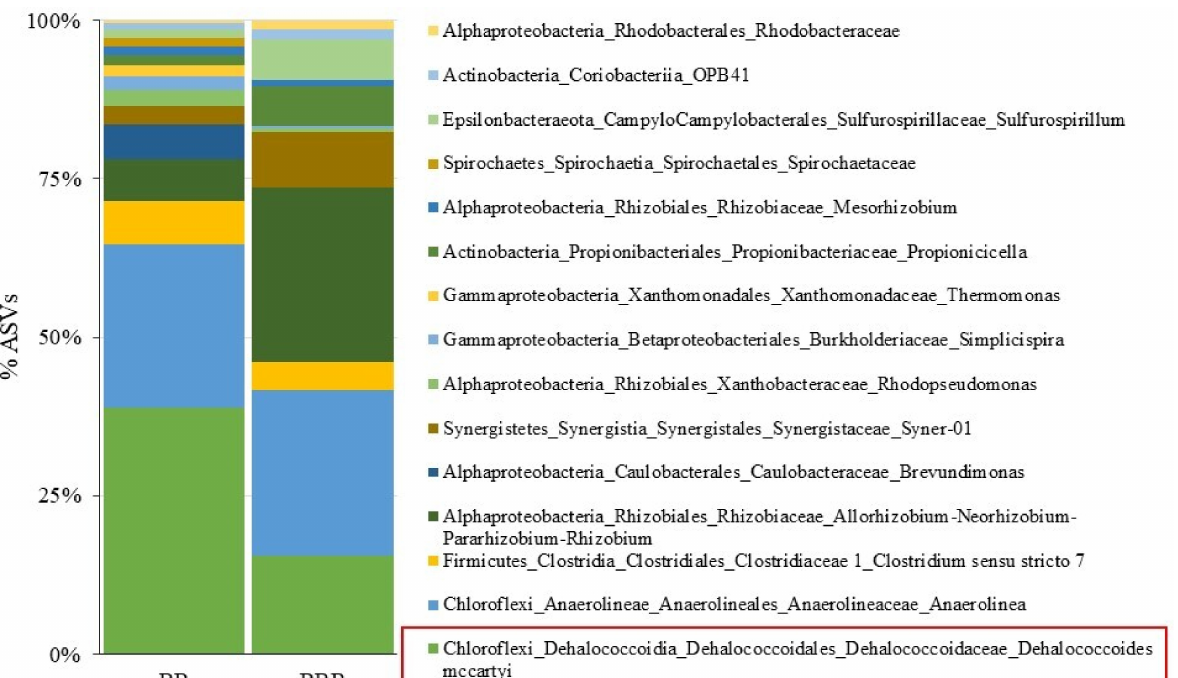
Figure 6. Microbiome composition of the BR and the BBR evaluated via 16S rRNA gene amplicon